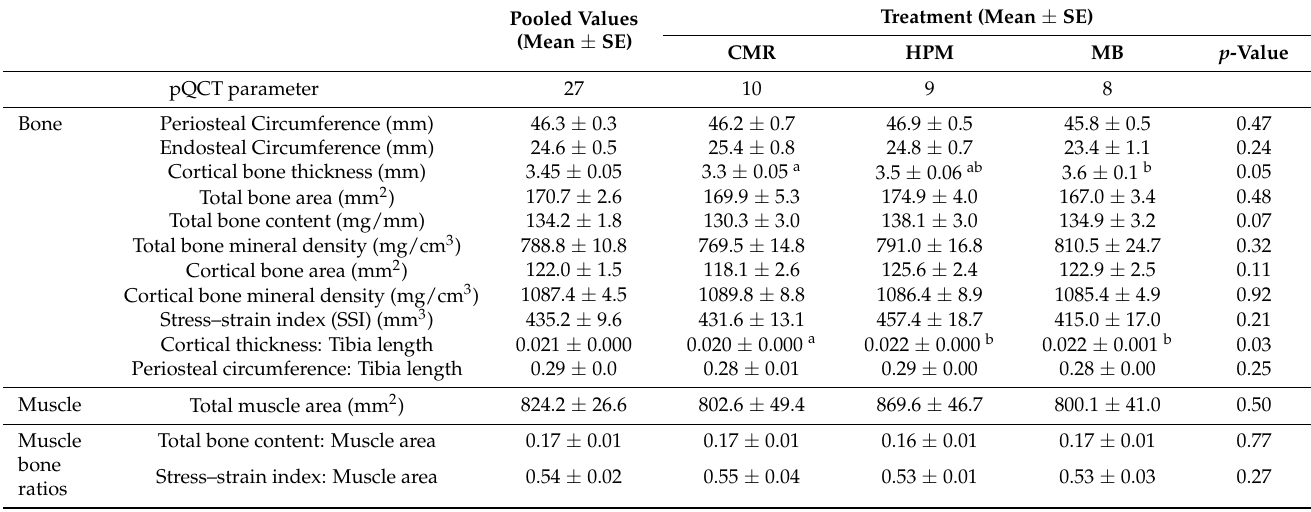
bone ratios Stress–strain index: Muscle area